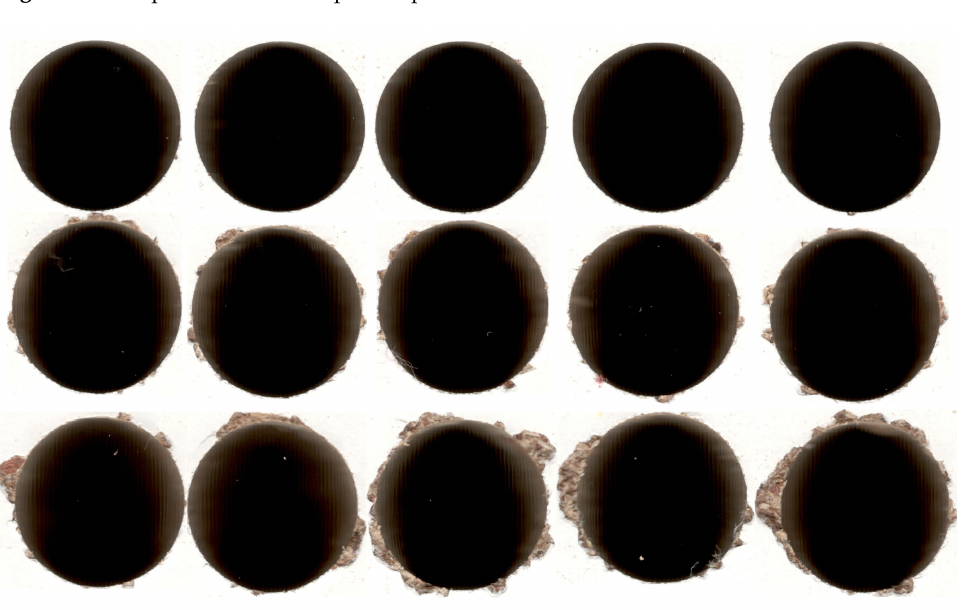
Figure 2. Example of a scan of chipboard profile with drilled holes.